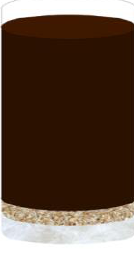
Figure 1. Schematic illustration of a coconut fiber column. The pore volume (Vp) was estimated by calculating the difference in weight between the saturated columns after the excess water had been drained and the weight of the dry column. The Vp was added at a constant flow rate (6 mL/min) by using a Gilson peristaltic pump, model Minipuls3 at intervals of 24